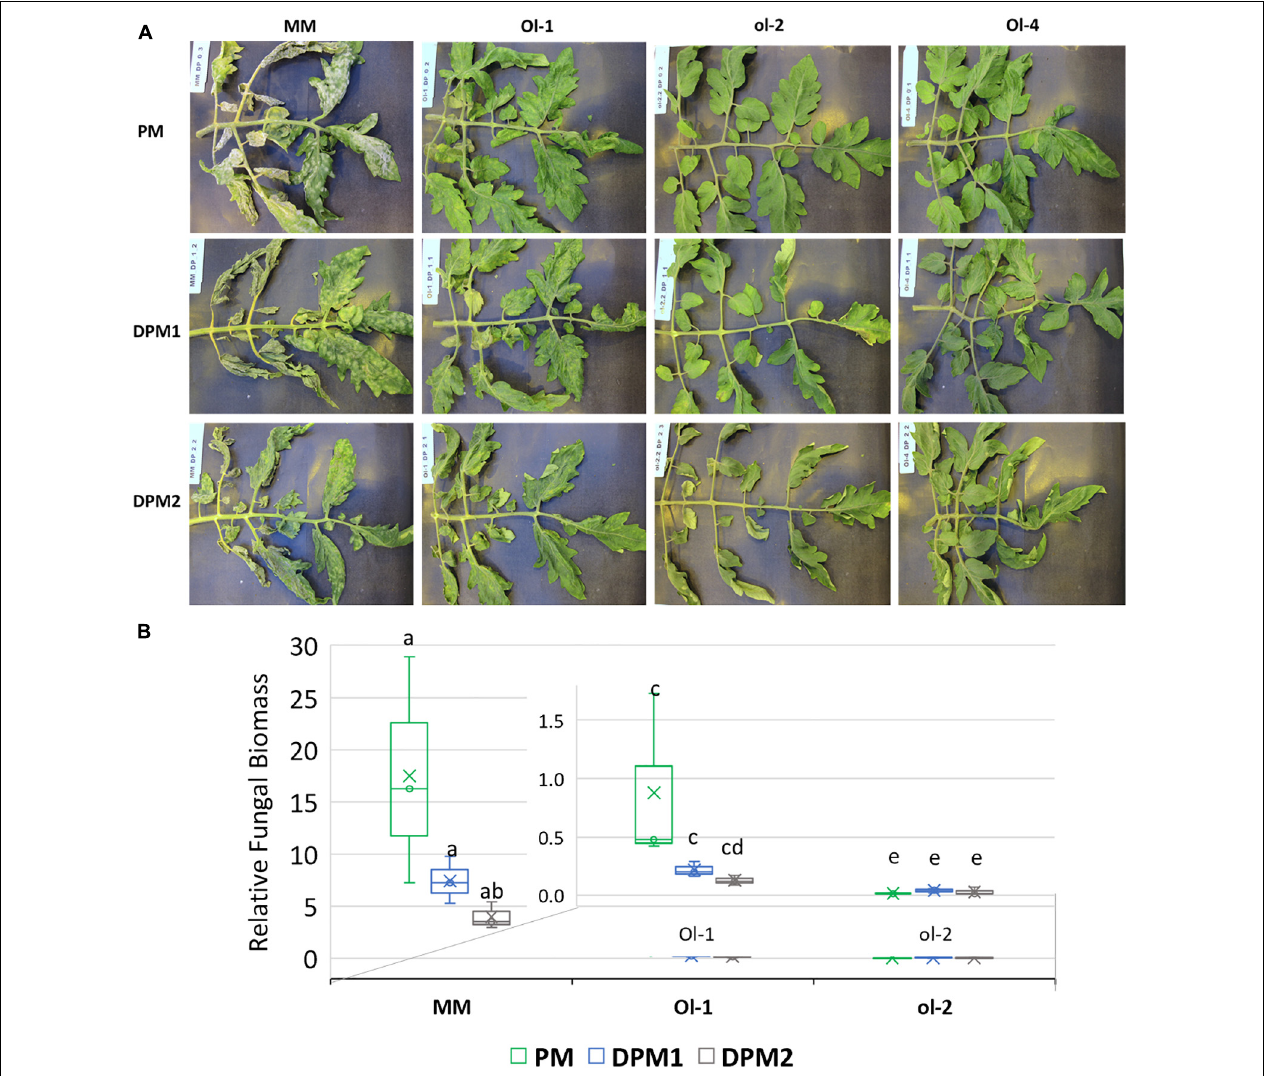
FIGURE 2 | (A) Disease symptoms visible as fungal sporulation on the adaxial surface of MM, Ol-1, and Ol-2 leaves under PM and combined stress. (B) Relative fungal biomass in MM and Ol lines under powdery mildew infection alone (PM) and in combination with mild (DPM1) and severe (DPM2) drought stress levels. Relative fungal biomass was calculated using the 2 - (cid:49) Ct method (Livak and Schmittgen, 2001) as the ratio between fungal and tomato gDNA. Leaf samples for fungal biomass quantification and pictures were taken at 14